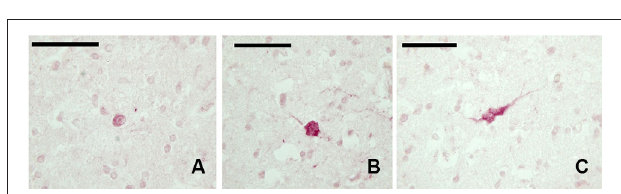
FIGURE 3 | CB-ir neurons in the claustrum. (A–C) Immunoreactive neurons in paraffin-embedded sections. Scale bars etc.